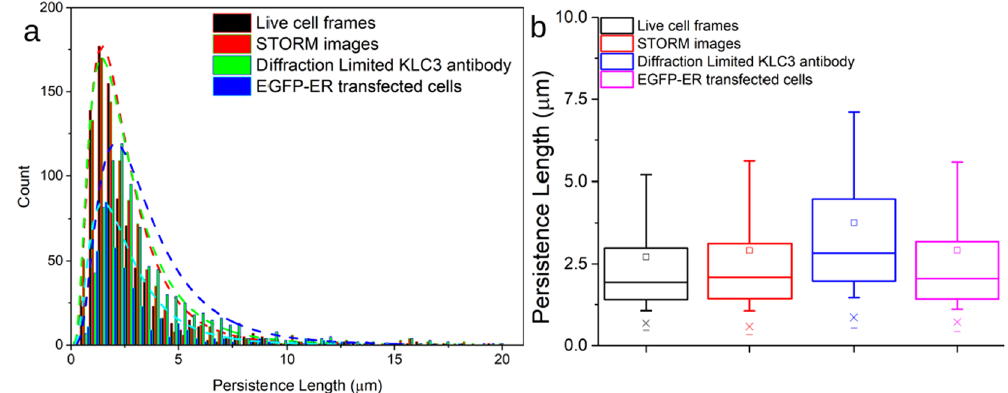
Figure 2. The persistence length ( L p ) of the endoplasmic reticulum of fixed MRC5 cells (STORM imaging of anti-KLC3, diffraction limited KLC3 antibody and EGFP-ER transfected cells) and live MRC5 cells (conventional diffraction limited fluorescence microscopy). ( a ) A histogram for the distribution of the persistence lengths for the differently labelled cells. The distribution of persistence lengths all follow log-normal distributions for the four differently labelled types of ER images in MRC5 cells. ( b ) The mean persistence length values extracted from the four differently labelled MRC5 cells agree within error (a 95% confidence interval) i.e. diffraction limited live cells, STORM, diffraction limited KLC3 antibody and EGFP-ER transfected fluorescence